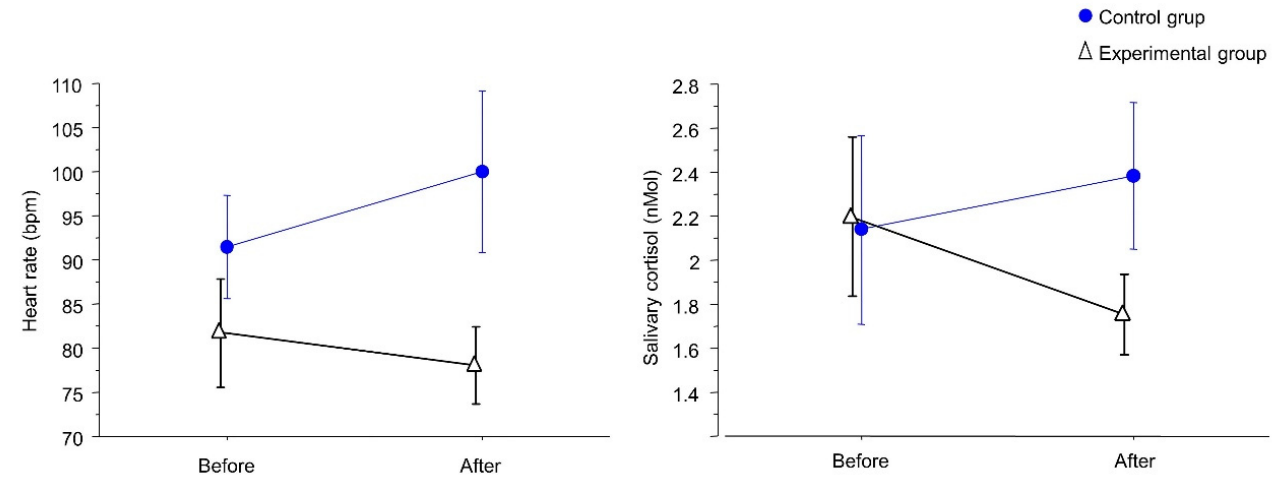
Figure 2. Influence of the crocodile case for carpule, on heart rate and salivary cortisol levels. The points show the mean ( ± standard deviation) of heart rate and salivary cortisol before and after anesthesia ( p < 0.05).